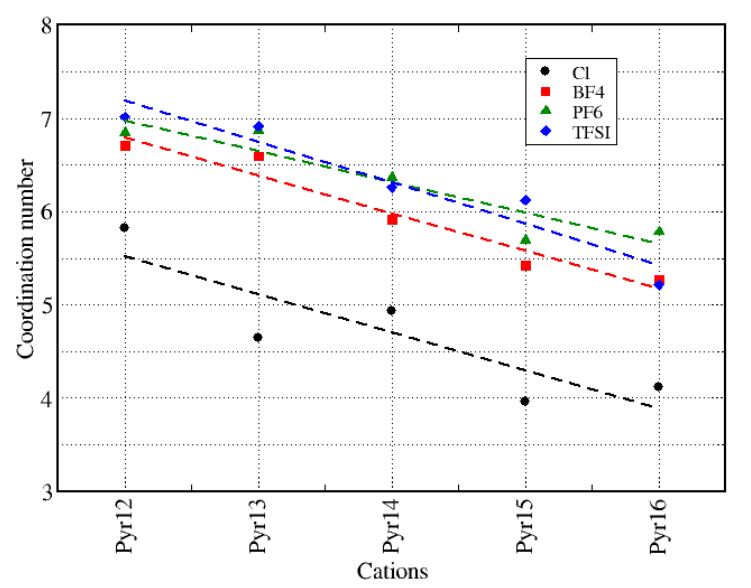
Figure 4. Coordination number (CN) of all neat ionic